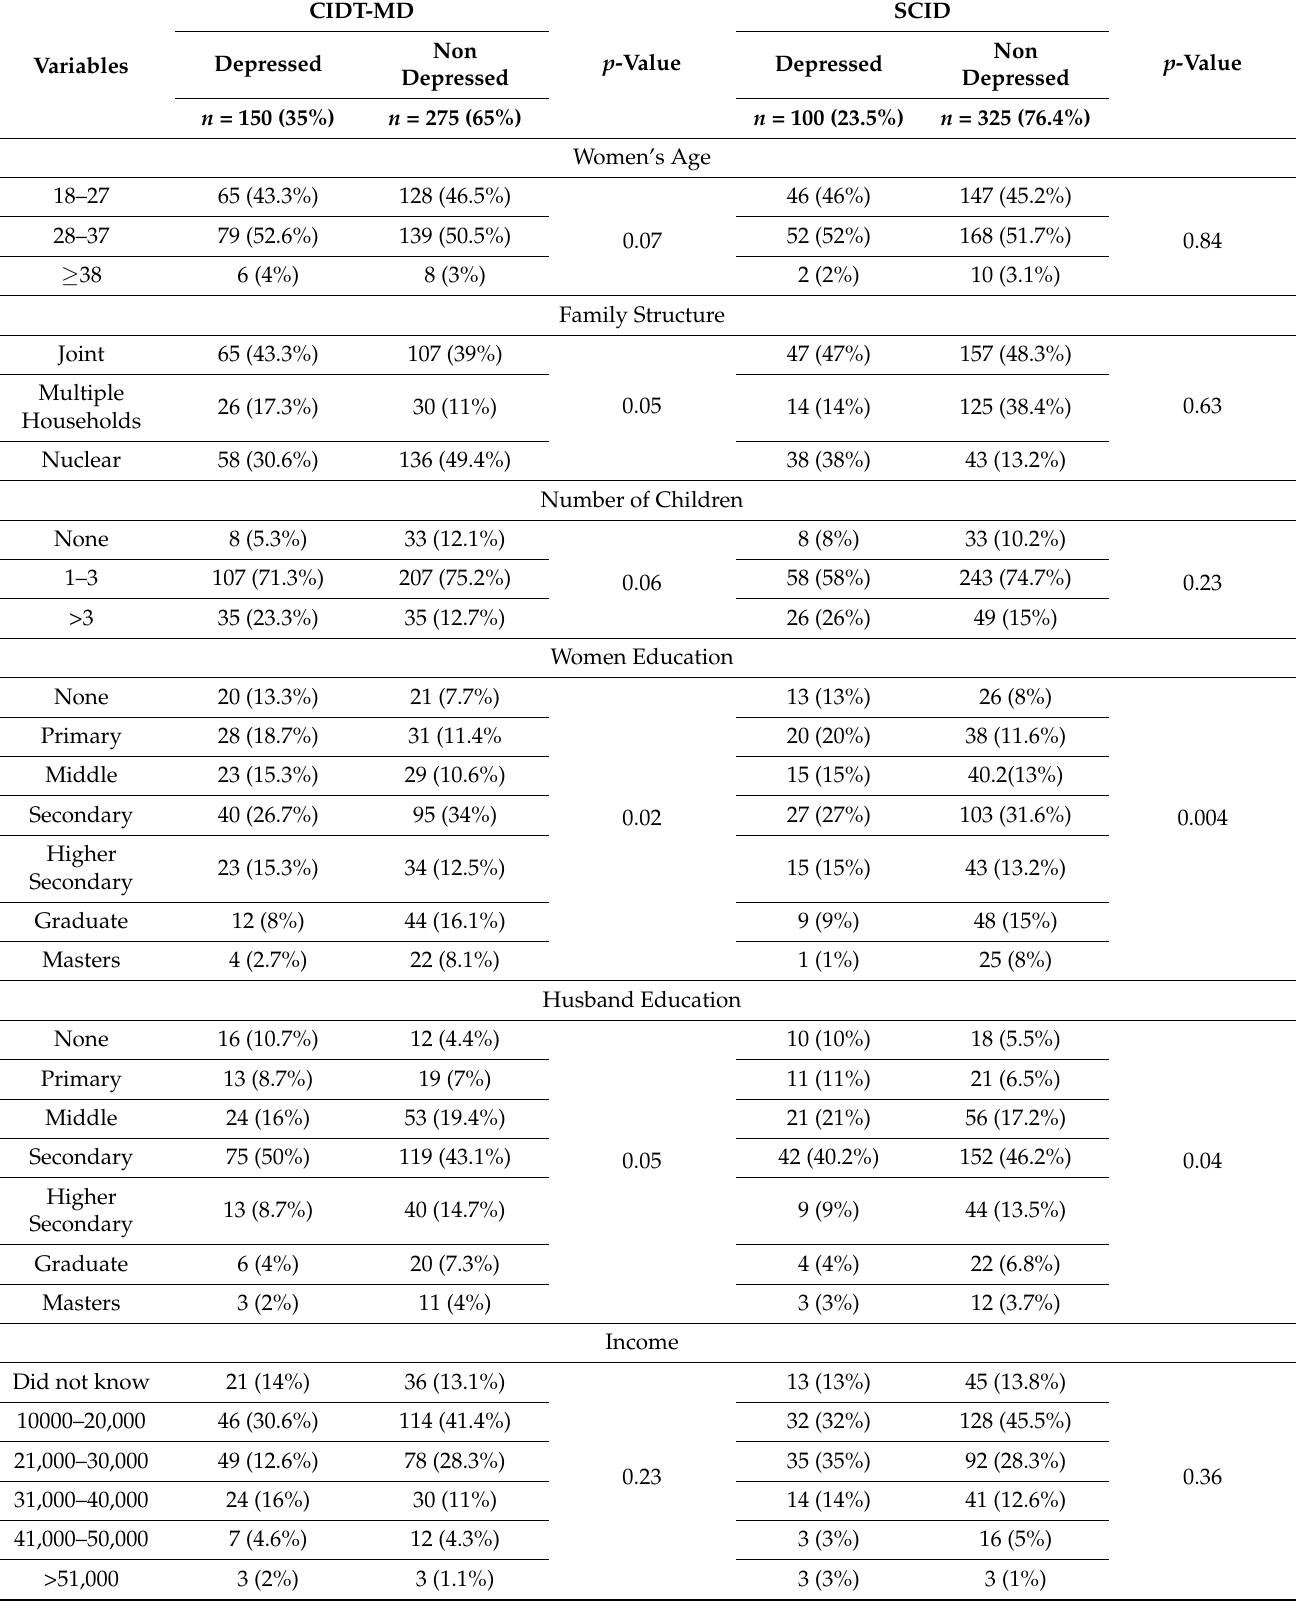
Table 1. Demographic characteristics of study participants ( n =